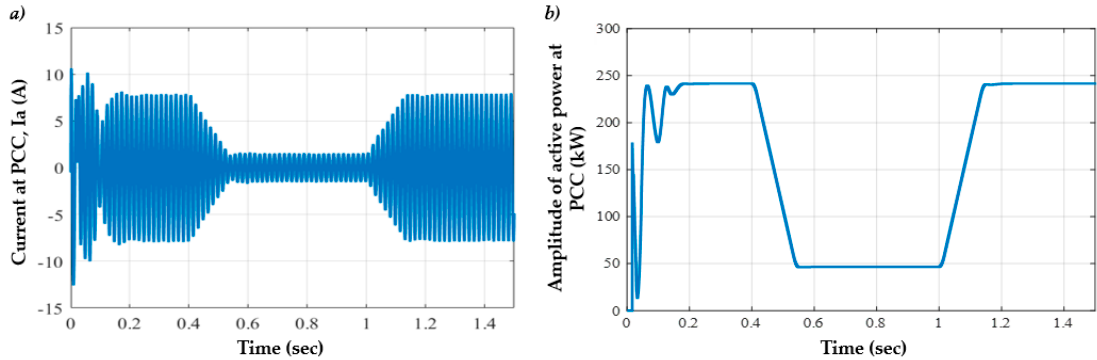
Figure 4. ( a ) 3-phase current waveforms at point of common coupling (PCC); ( b ) 3-phase active power at the point of common coupling (PCC).